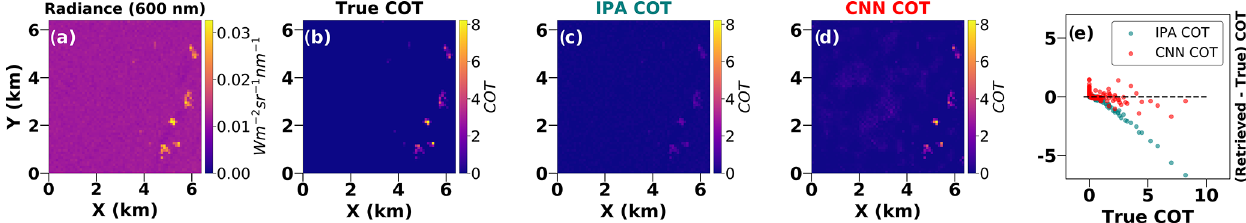
Figure 12. (a) An image of the 64 × 64 (6.4km × 6.4km) radiance channel (600nm) taken from the Sulu Sea (Sect. 2.1.1) but not shown to the CNN during training. (b) The corresponding 64 × 64 COT. (c) COT as retrieved by the IPA method of the image in (a) . (d) COT as retrieved by the CNN trained using methods explained in Sect. 4.3. (e) A scatter plot that compares the IPA and CNN retrievals, with the former underestimating for large COTs.